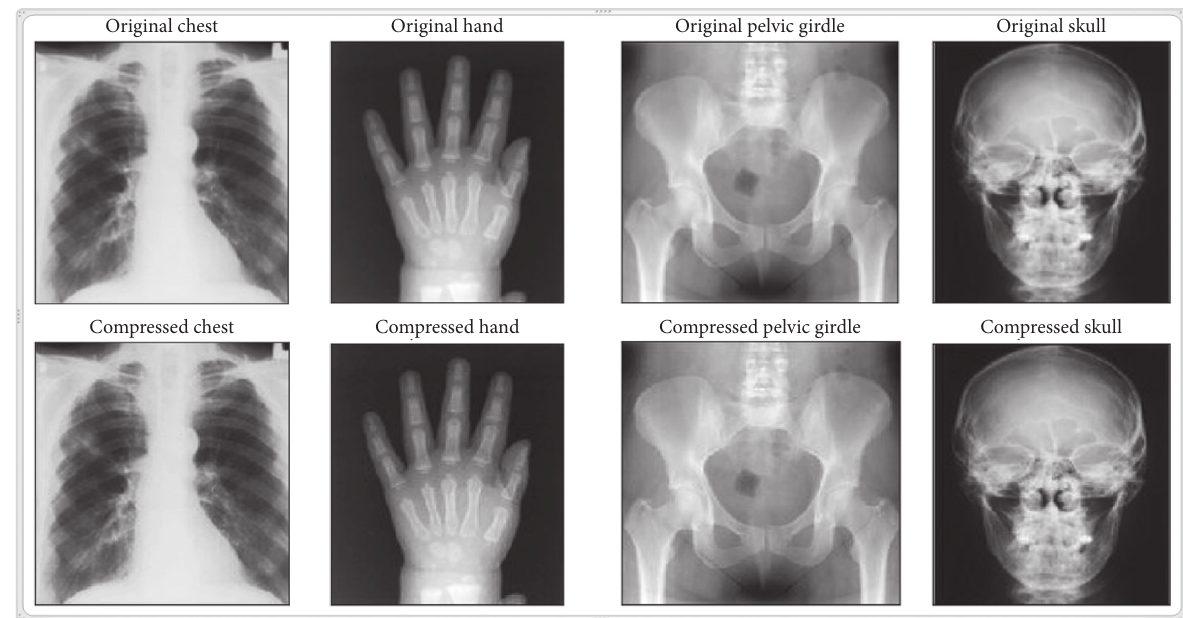
Figure 5: Samples of the original and compressed medical images using the proposed method. Table 3: Summary of the performance measures for the proposed compression method at ∝ � 0.8. This study ( ∝ � 0 . Category